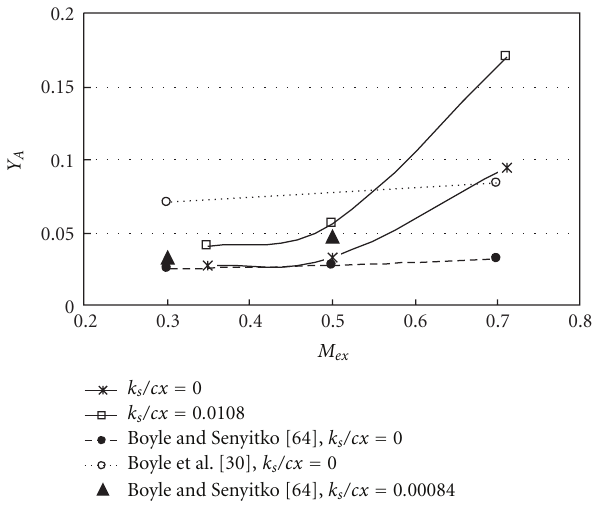
Figure 21: Comparison of area-averaged loss coe ffi cient with Boyle and Senyitko [64], and Boyle et al. [30], for a cambered vane with Tu = 1.1–1.6 percent [38].